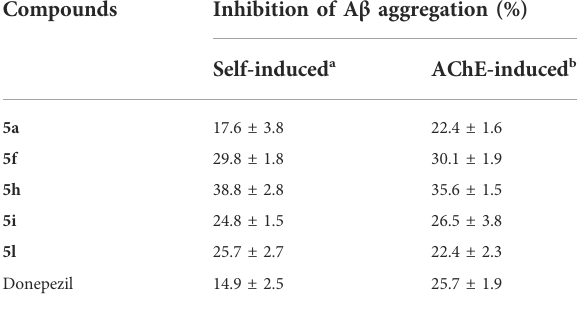
TABLE 2 Inhibition of self-induced and AChE-induced A β 1 – 42 aggregation by selected compounds. Compounds